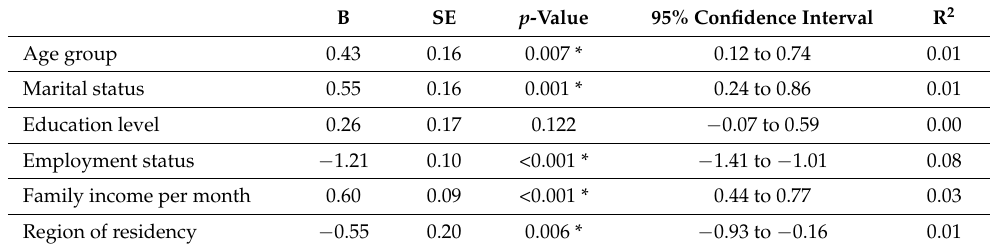
Table 3. Predictors of awareness related to cervical cancer.